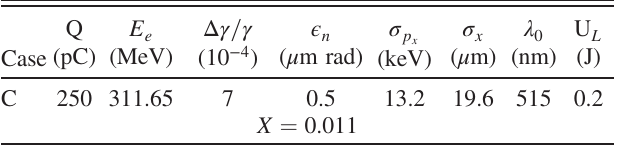
TABLE II. Interaction parameters for ELI-NP-GBS. σ L ¼ 14 μ m, σ 1 . 5 ps. t ¼ Case